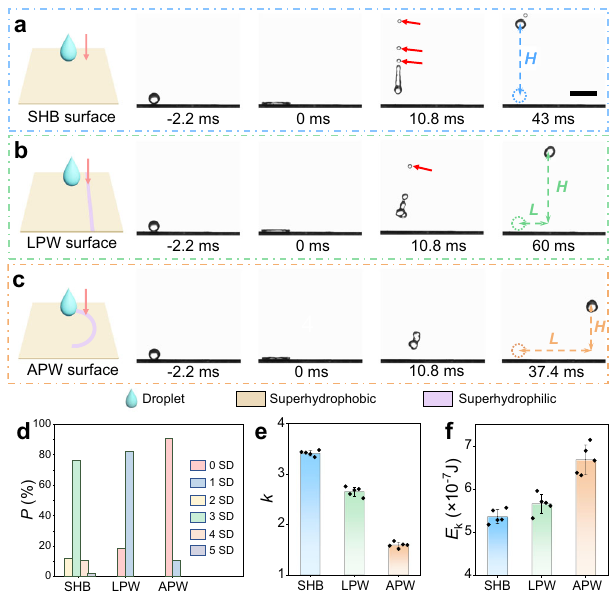
Fig. 1 Retraction of the droplets impacting on substrates with diverse wettability. a – c Side view of the water droplets impacting on the superhydrophobic (SHB) surface, the line-patterned-wettability (LPW) surface, and the arc-patterned-wettability (APW) surface. Scale bar: 5 mm. W e = 32.8. d Probability distribution of the satellite drop (SD) number of 3 surfaces (50 impacts for each surface). e k (de fi ned as the ratio of droplet elongation length and droplet diameter D ) of the 3 surfaces. f The rebounding kinetic energy E k of the main droplets of the 3 surfaces. The error bars of the data in e , f are obtained from the s.d. (standard deviation) of 5 independent